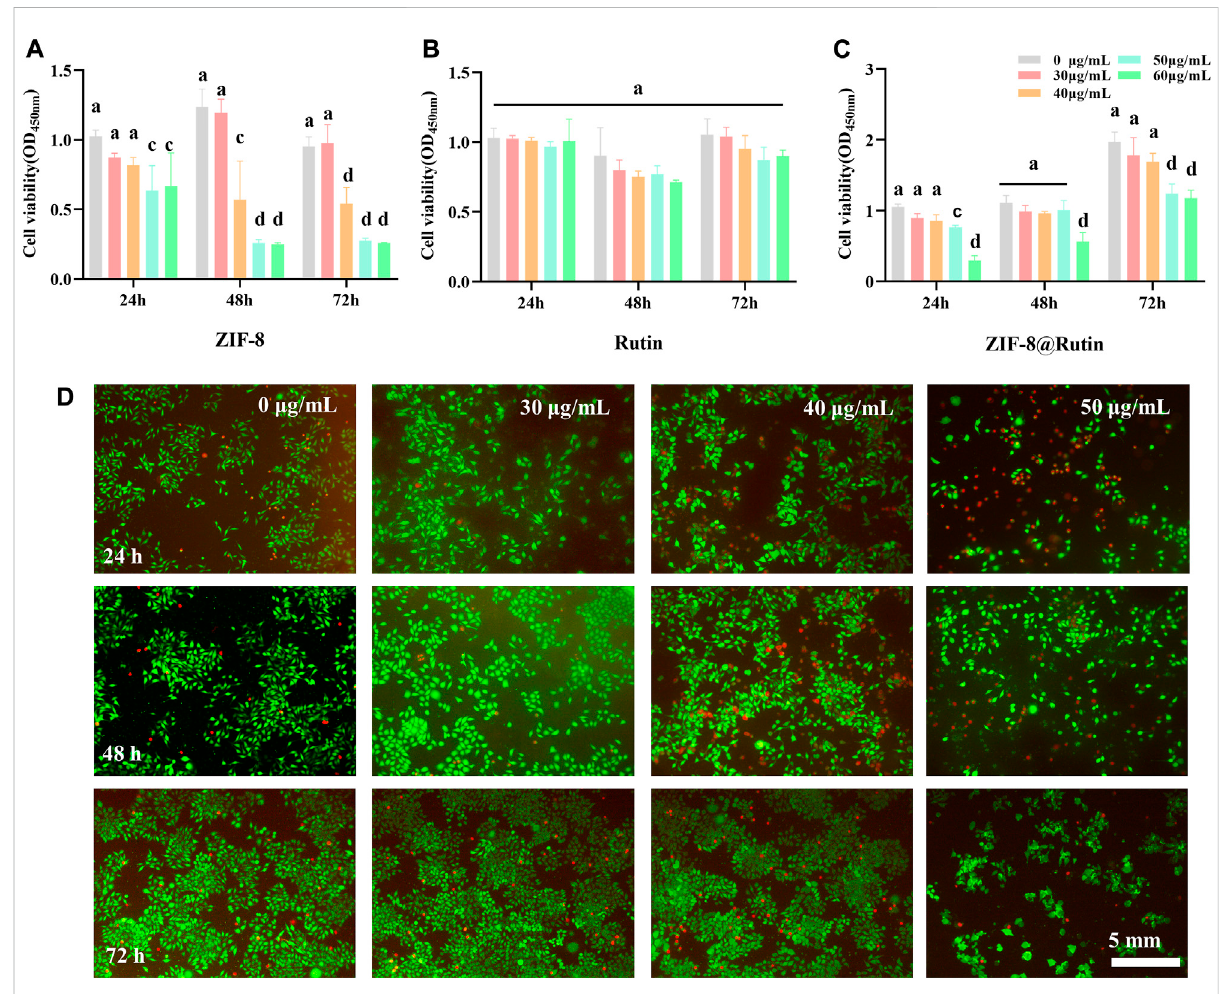
FIGURE 3 CytotoxicityofZIF-8,RutinandZIF-8@Rutinnanocomposites. (A – C) VigorofHGFsincubatedwithZIF-8,RutinandZIF-8@RutinNPs(0,30,40, 50, 60 μ g ml − 1 ) for 24 h, 48 h, and 72 h respectively. A 96-well plate without NPs (0 μ g ml − 1 ) was used as a blank control. The solid line represents whether the experimental group is statistically different compared to the blank control. (D) Representative images of HGF cultured with 30 μ g ml − 1 , 40 μ g ml − 1 , and 50 μ g ml − 1 of ZIF-8@Rutin NPs. Live cells were represented in green; dead cells were in red. Dissimilar letters indicated values that were signi fi cantly different from each other group ( n = 6, p <